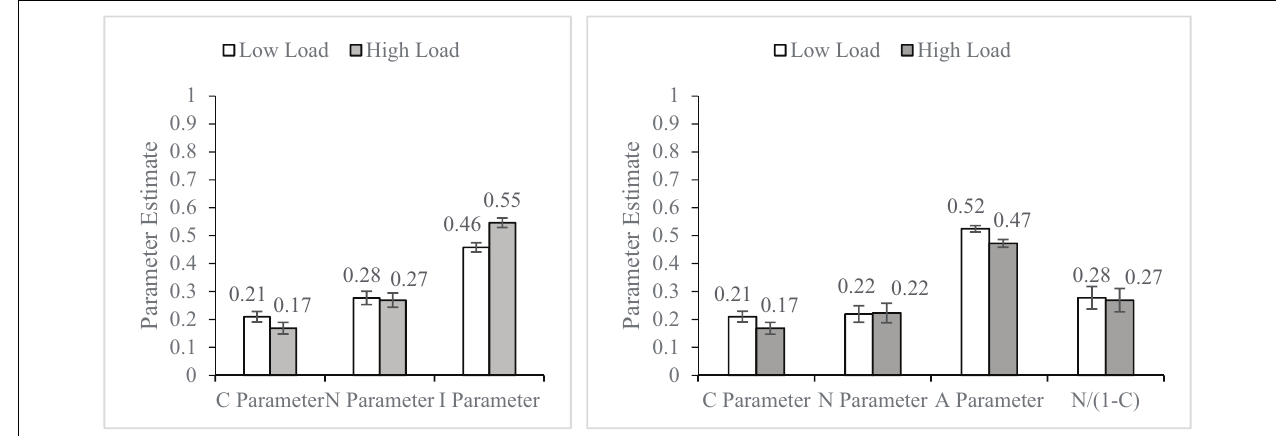
FIGURE A2 | Results of Study 2b by Gawronski et al. (2017) obtained from the CNI model (left) and CAN algorithm (right) . Error bars represent ± 1